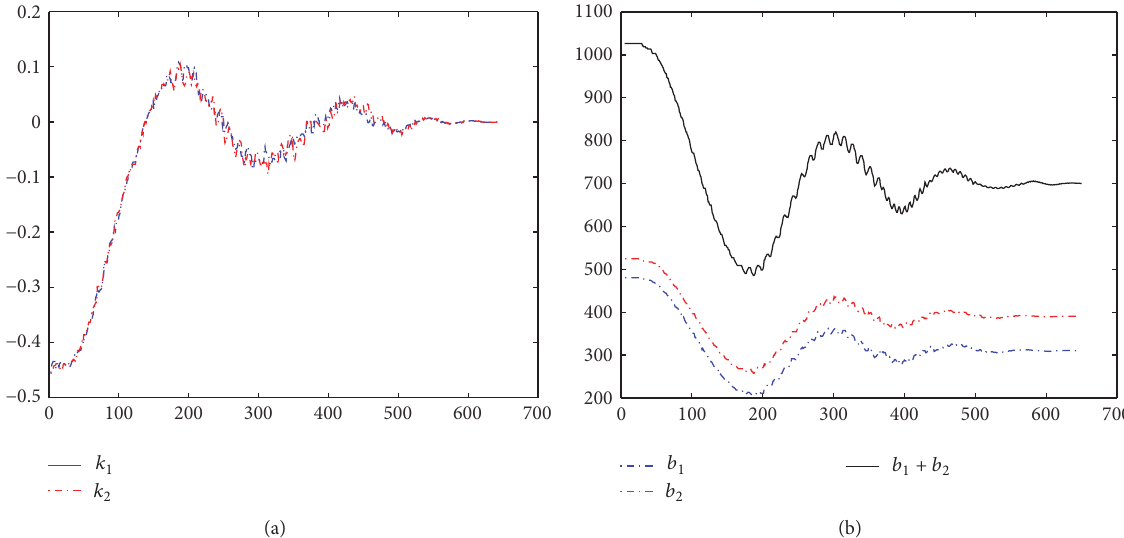
Figure 13: Measurement value curves of slope 𝑘 (a) and intercept 𝑏 (b) of the detected edge lines. All curves converge at about 500th frame.